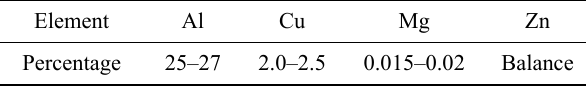
Table 1 Chemical composition (wt. %) of ZA-27 alloy .